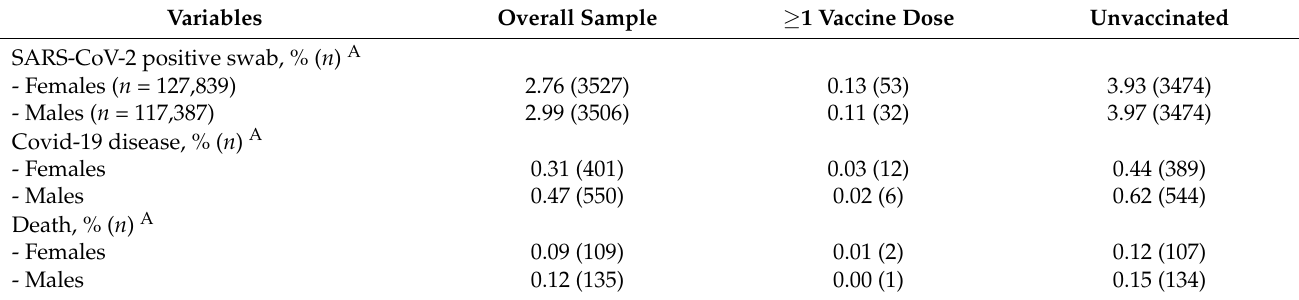
Table 3. Main characteristics and outcomes of the sample, stratified by gender and vaccine